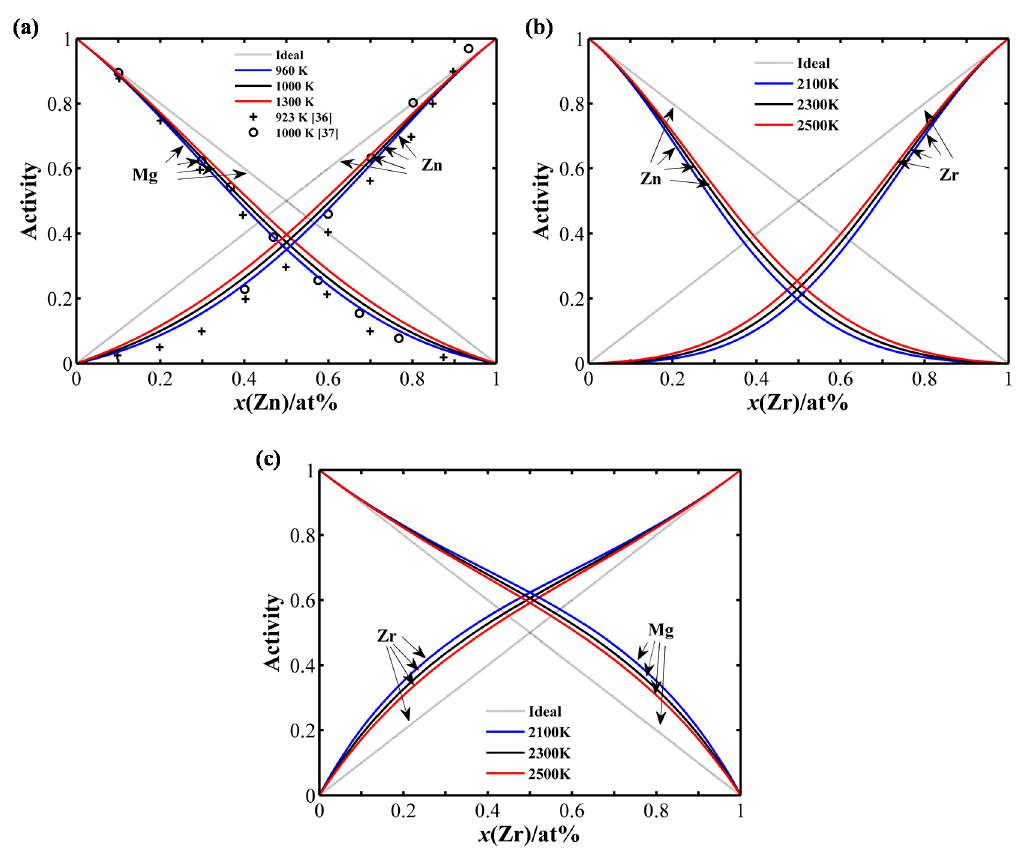
Figure 3. Calculated activities of the component of liquid Mg-Zn ( a ), Zn-Zr ( b ), and Mg-Zr ( c ) binary alloys with experimental data from the literature [36,37] at different temperatures.